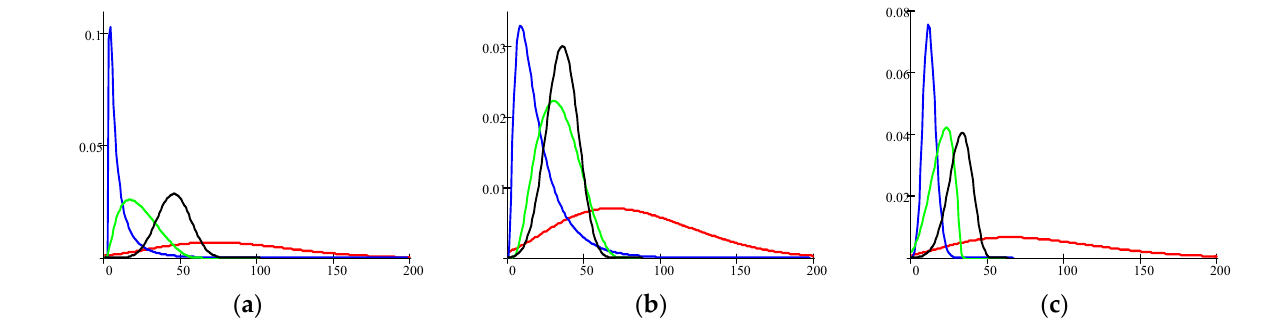
Figure 17. Approximated distributions of features (R ( a ), G ( b ), and B ( c ) values) for four classes; red color curves—Urban, blue color curves—Water, green color curves—Vegetation, and black color curves—Bare Soil.